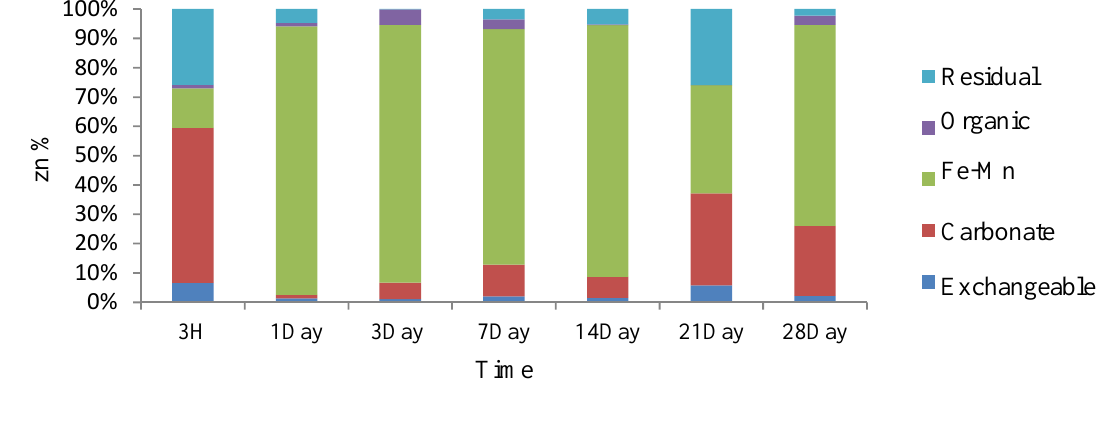
Figure 3. Different fractions of Zn in blank soil (%) Table 4. Different fractions of Zn in blank soil (mg/kg -1 )